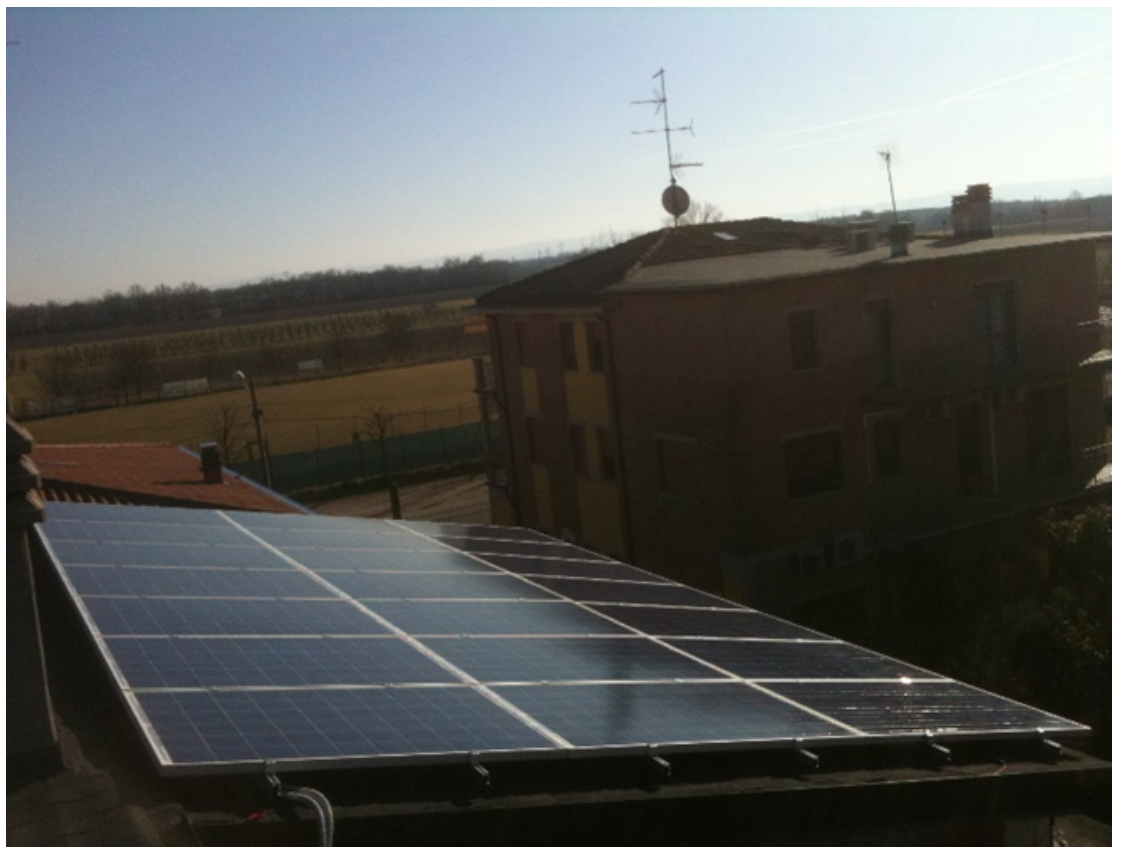
Figure 1. PV power